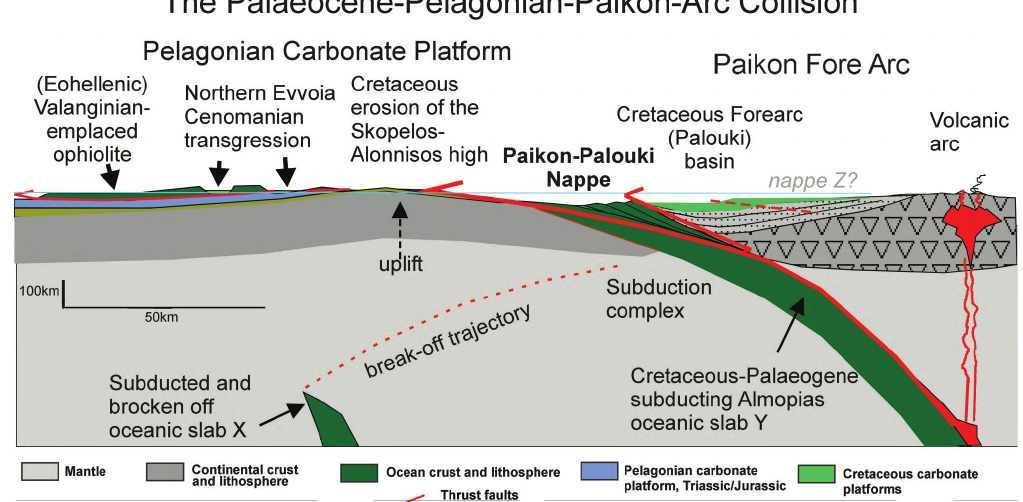
Cartoon of the Palaeocene, Pelagonian– Paikon arc collision (approximate scale). The Eohellenic ophiolite (almopias oceanic crust) was obducted westwards onto the eastern, continental Pelagonian plate, and the eastern almopias plate subducted eastwards beneath the Paikon arc. Two subductions are indicated: slab x (= the leading oceanic edge of the Pelagonia), and slab y (= the eastern half of the almopias plate). slab x is supposed to have broken off during the Early Cretaceous, thereby liberating the relatively buoyant eastern-Pelagonia and initiating uplift and erosion on the sporades. Continued convergence finally caused the collision of eastern Pelagonia with the Cretaceous, carbonate-forearc basin, whereby the Paikon arc acted as a backstop. The Cretaceous carbonate platform overthrust eastern Pelagonia (sporades) together with scraped off ocean floor mélange (shear zone formation) (see